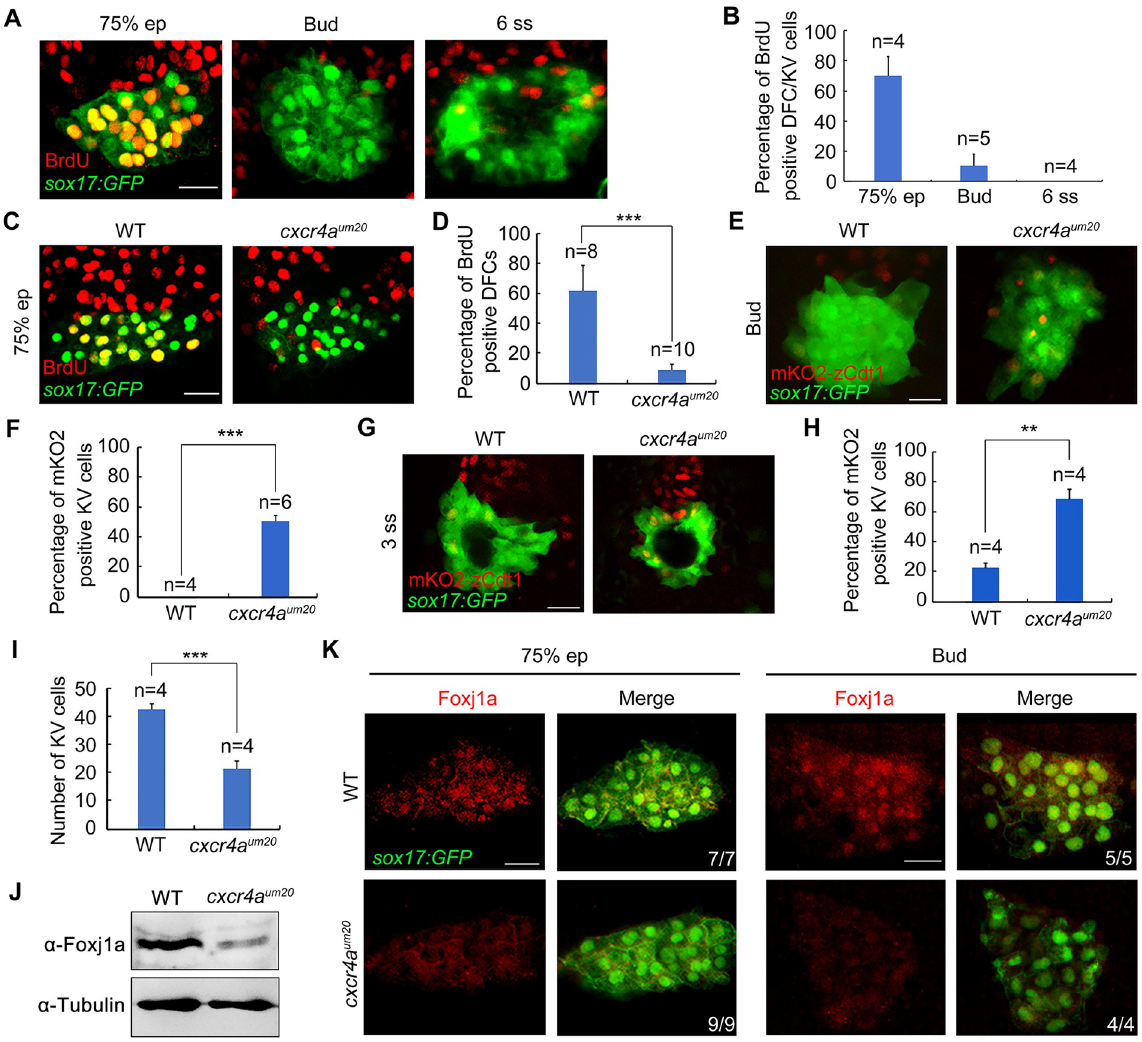
Fig 3. Depletion of cxcr4a impairs G1/S transition and Foxj1a protein expression in DFCs. (A–B) Representative confocal sections of BrdU- positive DFCs and KV cells at the indicated stages (A). Dorsal views with anterior on the top. Scale bar, 20 μ m. The percentage of BrdU-positive cells among GFP-positive DFCs and KV cells were quantified from the indicated embryo numbers in three independent experiments, and the group values are expressed as the mean ± SD (B). Underlying data can be found in S1 Data. (C-D) BrdU incorporation experiments showed reduced proliferating DFCs in cxcr4a um20 mutants at the 75% epiboly stage. Scale bar, 20 μ m. Statistical data from three independent experiments are shown in (D). Student t test, ��� P < 0.001. Underlying data can be found in S1 Data. (E–I) Depletion of cxcr4a inhibits the G1/S transition in DFCs. Representative confocal sections of WT and cxcr4a -deficient Tg(sox17 : GFP;EF1 α : mKO2-zCdt1(1/190)) embryos at the bud and 3-somite stages are shown in (E) and (G). Dorsal views with anterior to the top. Scale bar, 20 μ m. The percentage of mKO2-positive KV cells were quantified from three independent experiments (F and H). The average numbers of KV cells in WT embryos and cxcr4a um20 mutants at the 3-somite stage are shown in (I). The significance of differences compared with the WT group was analyzed with the Student t test, �� p < 0.01; ��� p < 0.001. Underlying data can be found in S1 Data. (J–K) cxcr4a deficiency down-regulates zFoxj1a protein expression levels. WT and cxcr4a -deficient Tg(sox17 : GFP) embryos were harvested at the 75% epiboly and bud stages and then subjected to western blot analysis (J) and immunostaining (K) with the indicated antibodies. Scale bar, 20 μ m. BrdU, bromodeoxyuridine; DFC, dorsal forerunner cell; Ef1 α , eukaryotic translation elongation factor 1 α ; ep, epiboly; Foxj1a, forkhead box j1a; GFP, green fluorescent protein; KV, Kupffer’s vesicle; mKO2, monomeric Kusabira Orange2; sox , SRY-box transcription factor; Tg , transgene; WT, wild-type; zCdt1, zebrafish chromatin licensing and DNA replication factor 1; zFoxj1a, zebrafish Foxj1a; α -Tubulin, acetylated tubulin.